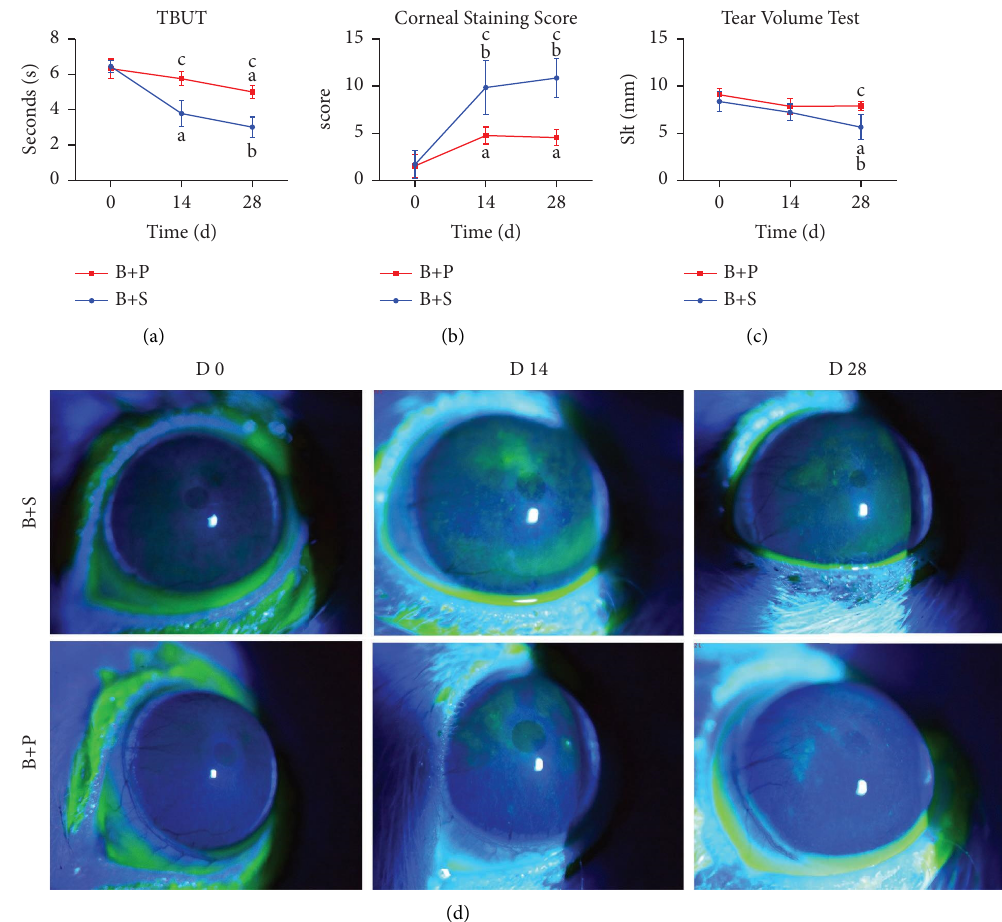
Figure 5: Clinical indicators of saline and the PDTC group after blue light stimulation. (a) Te PDTC-treated group showed an increased TBUT compared to the saline-treated group ( c P < 0 . 01). (b) Scores of fuorescence staining signifcantly increased with time ( c P < 0 . 01, b P < 0 . 05 compared with day 0 in the same group). PDTC showed a decreased score compared to the saline-treated group ( c P < 0 . 01). (c) In the B+S group, tear secretion decreased in a time-dependent manner (day 0 vs. day 28: a P < 0 . 01, day 28 vs. day 14: b P < 0 . 05) while the index changed slightly in the B +P group. (d) Representative examples of fuorescein sodium